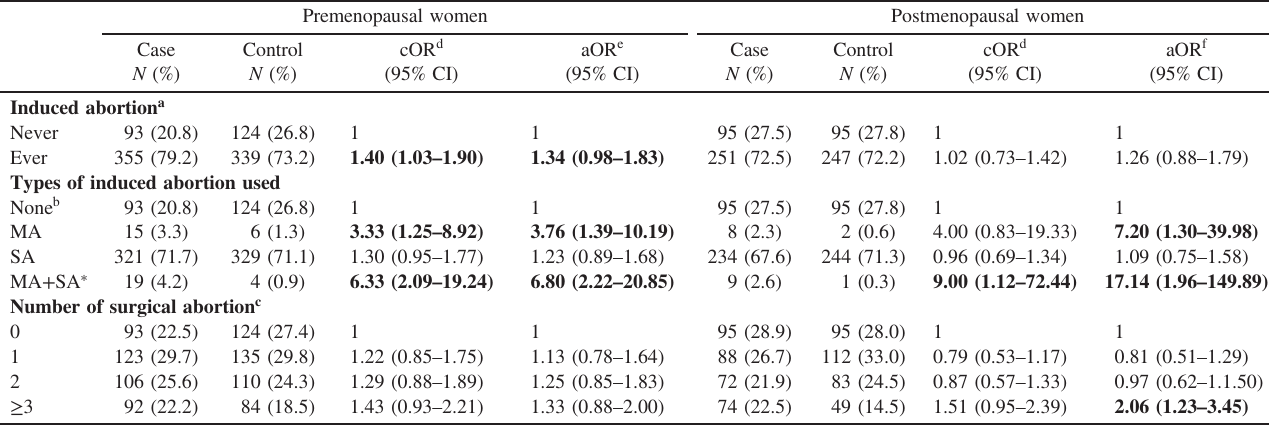
Table 1. Correlation between induced abortion and breast cancer risk